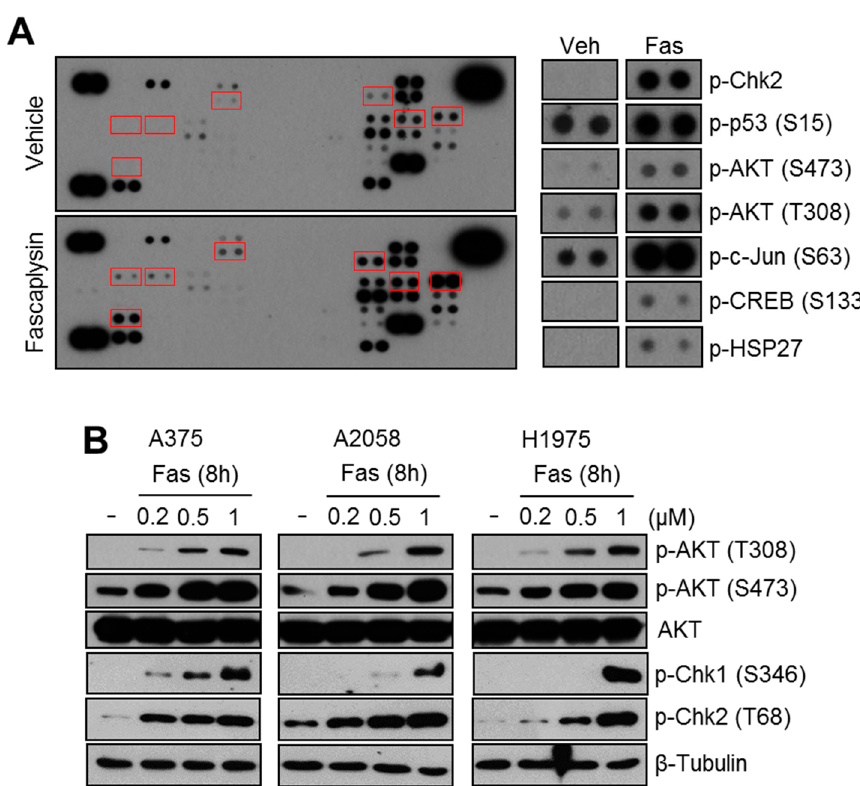
Figure 1. Fascaplysin increases AKT phosphorylation and DNA damage-induced signaling. ( A ) A375 melanoma cells were incubated with fascaplysin or dimethyl sulfoxide (DMSO) control for 8 h, and 300 μ g of total cell lysate was reacted with a phosphorylated kinase proteome profiler membrane. Up- or down-regulated kinases were identified. ( B ) A375, A2058, and H1975 cells were cultured in the absence or presence of the indicated concentrations of fascaplysin for 8 h, and then proteins were analyzed by Western blotting.